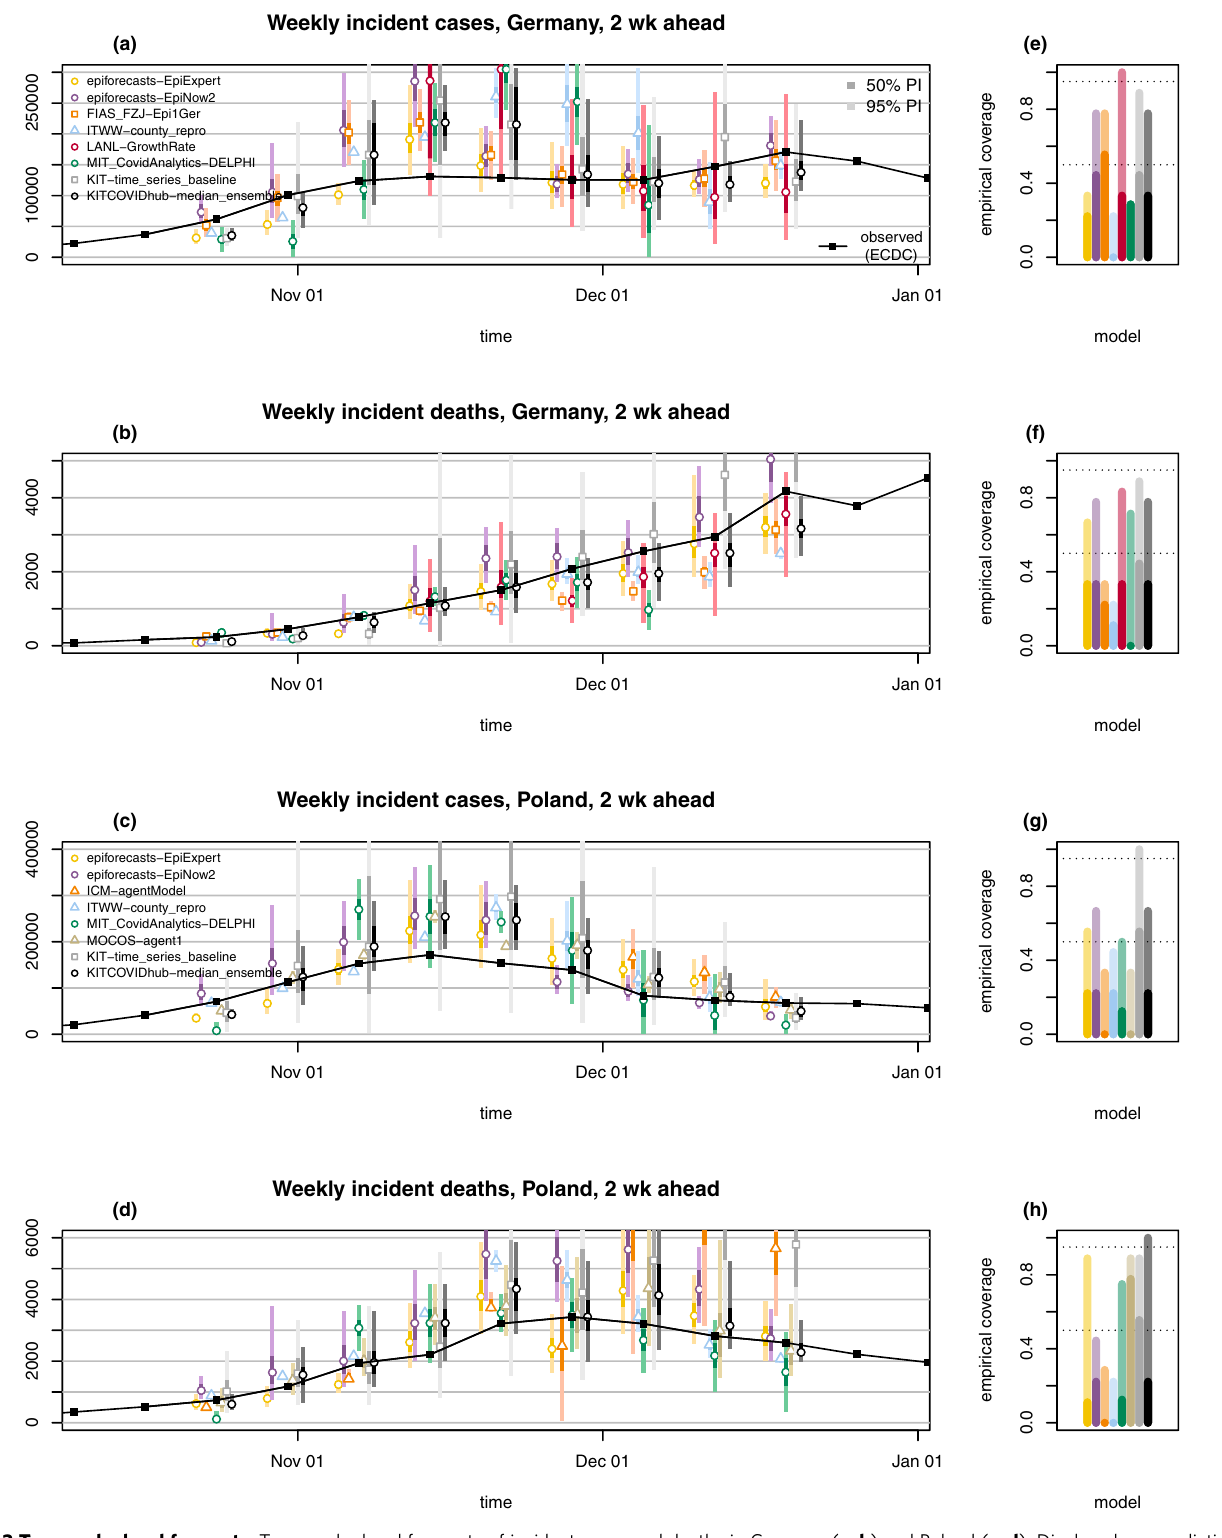
Fig. 3 Two-week-ahead forecasts. Two-week-ahead forecasts of incident cases and deaths in Germany ( a , b ) and Poland ( c , d ). Displayed are predictive medians, 50% and 95% prediction intervals (PIs). Coverage plots ( e – h ) show the empirical coverage of 95% (light) and 50% (dark) prediction